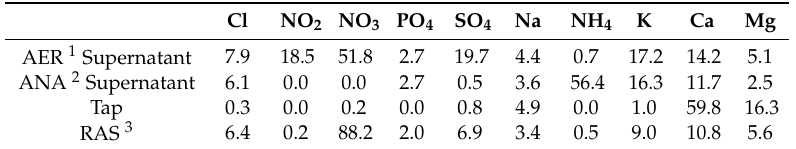
Table 1. Nutrient composition (mg/L) of the Recirculating Aquaculture System (RAS) and tap water, as well as AER and ANA supernatants, at the beginning of the